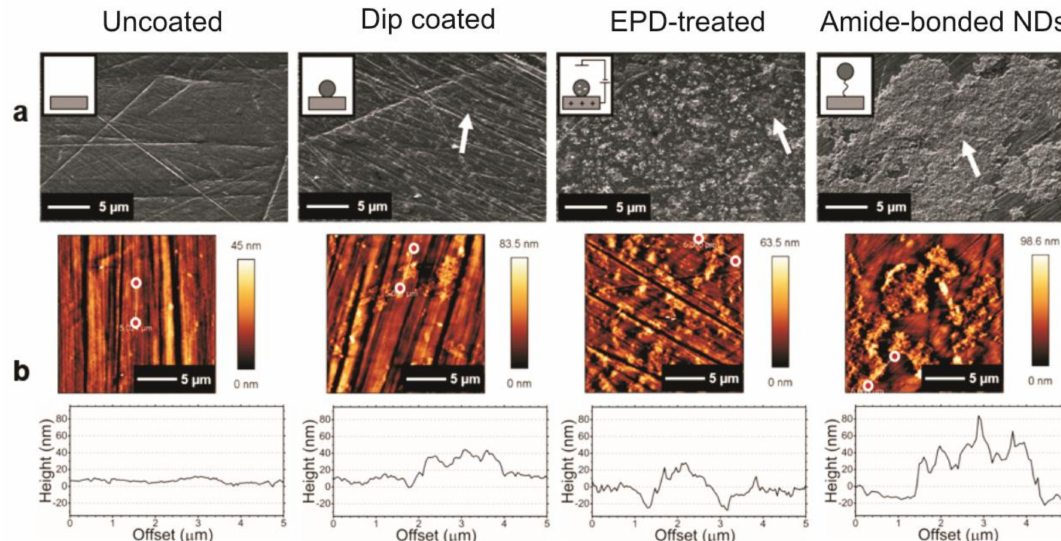
Figure 2. ( a ) Scanning electron microscopy (SEM) images and ( b ) atomic force microscopy (AFM) images, including the correlated profile measurements of dip-coated, electrophoretic deposition (EPD)-treated and covalently immobilized nanodiamonds (NDs) on native TiO 2 , in comparison to the uncoated